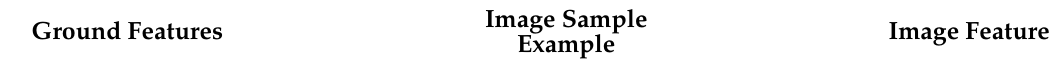
Table 1. Descriptions of UAV image